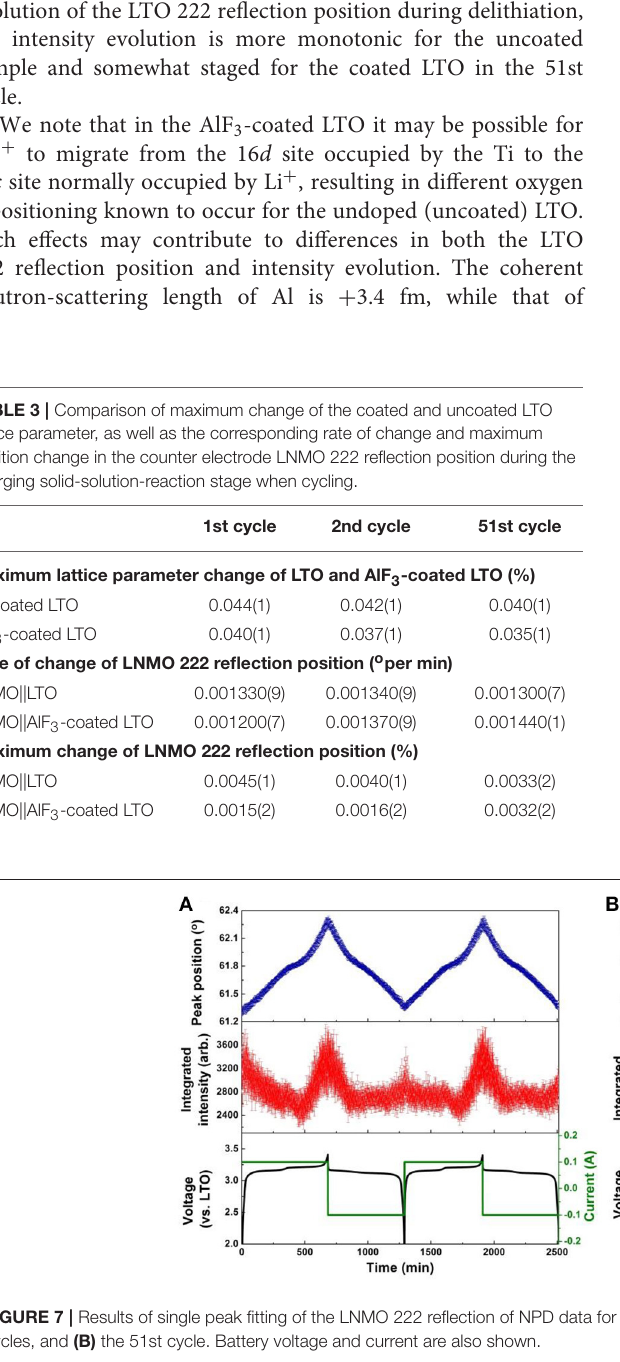
Frontiers in Energy Research |